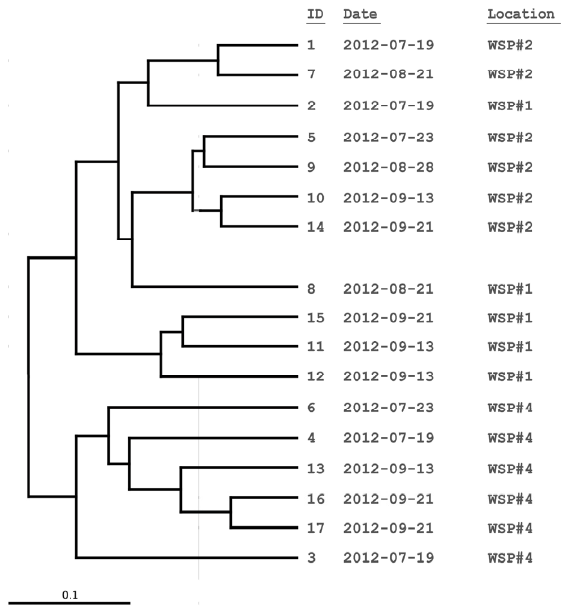
Figure 3. Hierarchal cluster analysis of samples based on diversities of the relative abundances, showing strong clustering of WSP#2 in one branch and WSP#1 and WSP#4 in another, and supporting the relative abundances observed in Figure 1.